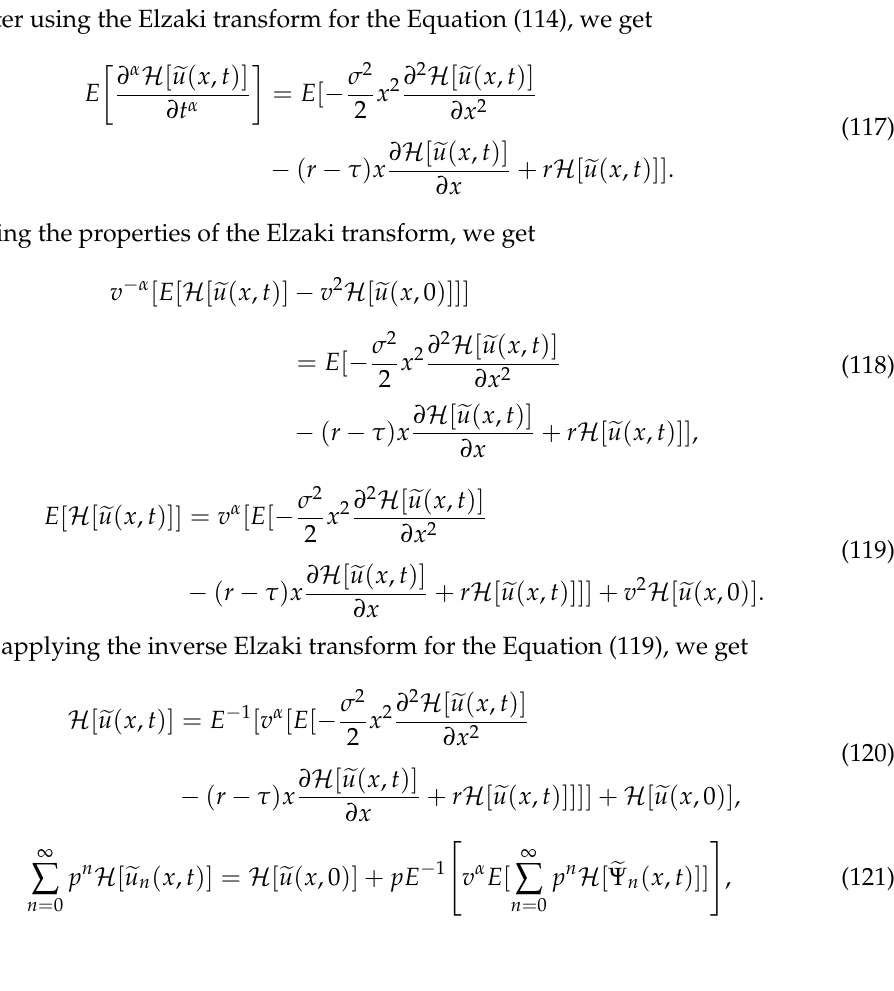
Figure 3. The fuzzy approximate solution (cid:101) u ( x , t ) of Example 2. Firstly, the ETHPM is used to solving the Example